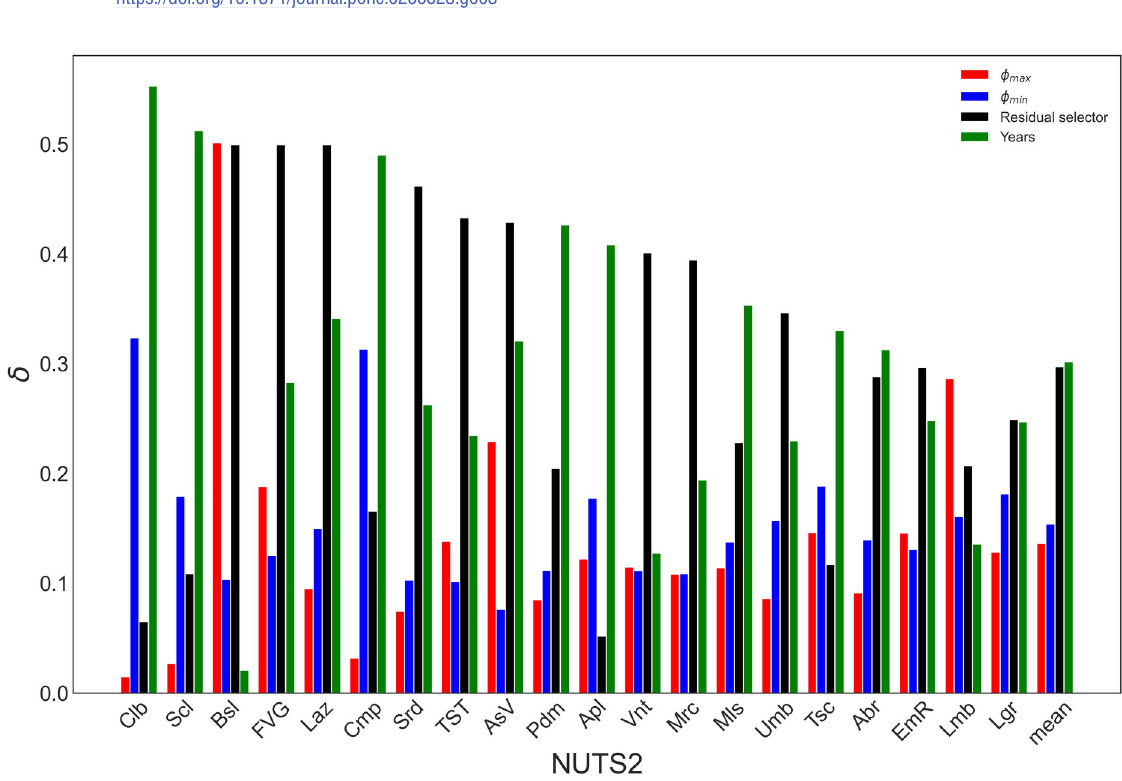
Fig 4. Conditional output distributions for Laz when fixing the uncertain input parameters.